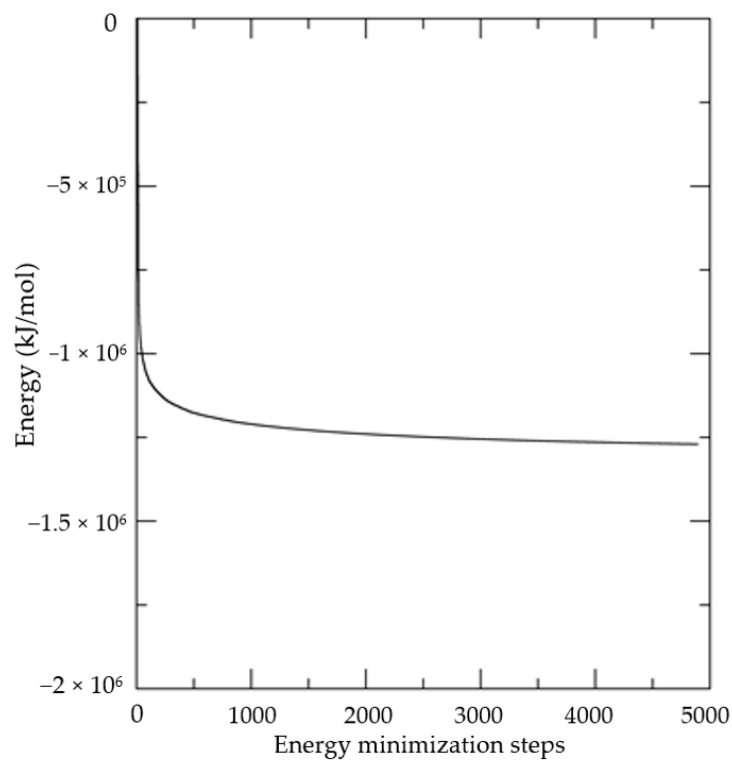
Figure 3. Complex minimization energy.